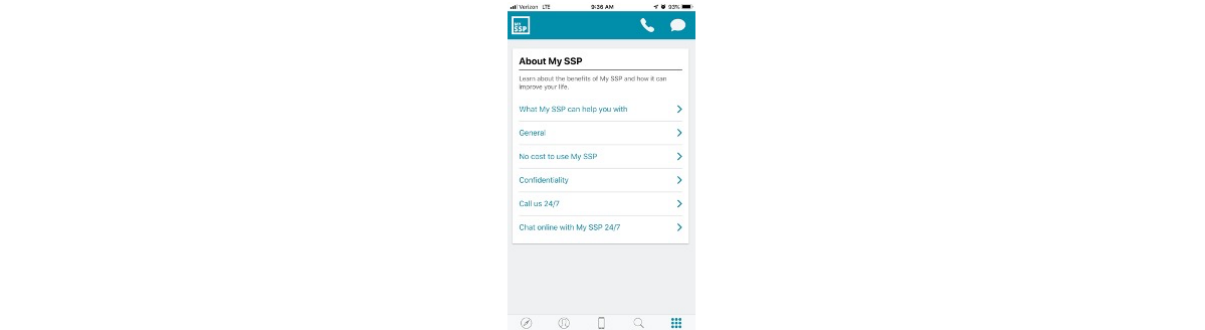
Figure 3. About screen for the MySSP